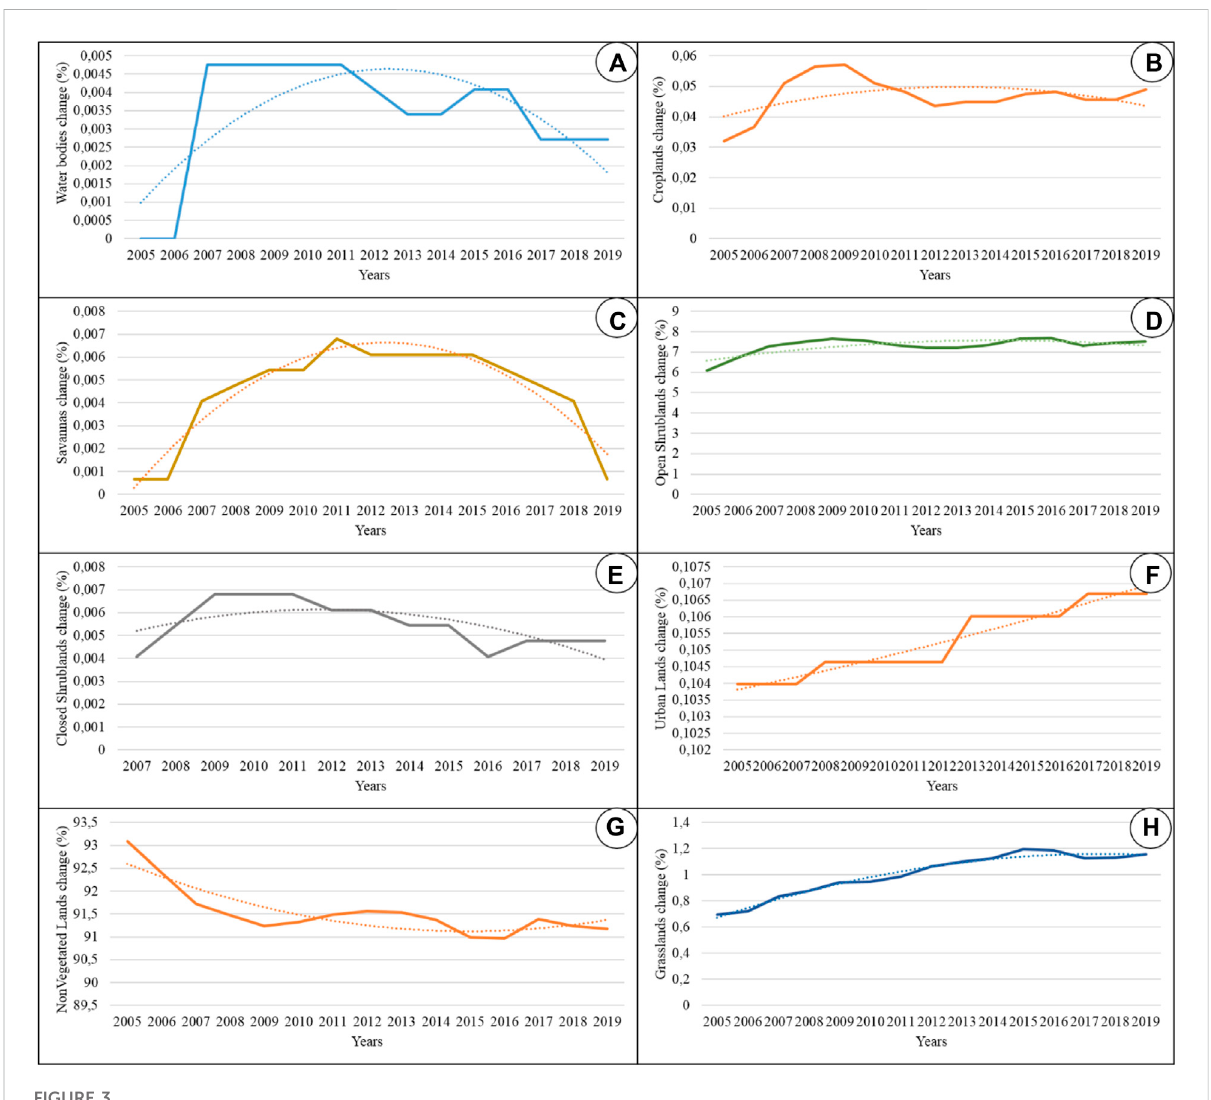
FIGURE 3 Landcoverandlandusepercentage(%)changeintheprovinceofErrachidia(SoutheasternMorocco)intheperiodbetween2005and2020. (A) water bodies; (B) croplands; (C) savannas; (D) open shrublands; (E) closed shrublands; (F) urban lands; (G) non-vegetated lands; and h, grasslands. Dotted lines: polynomial